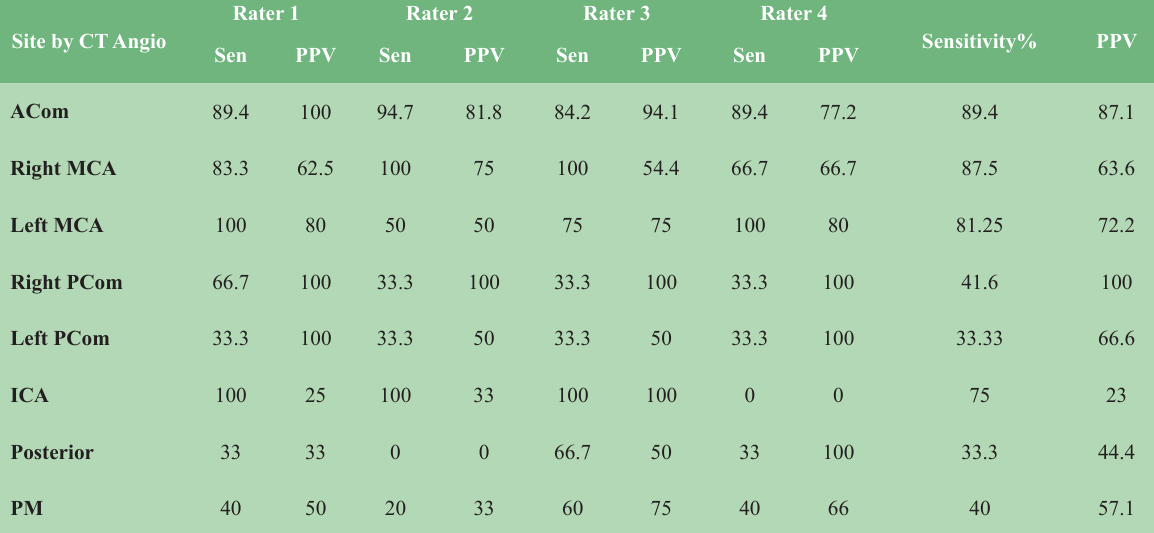
Table 5. Diagnostic power of prediction of aneurysms by 4 different raters in patients with single aneurysm Rater 1 Rater 2 Rater 3 Rater Site by CT Angio